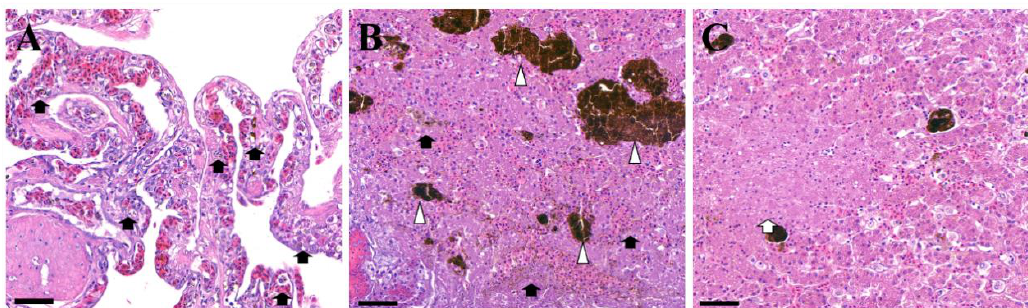
Figure 2. Microscopic examinations. Shown are the microscopic findings in the ( A ) lung and ( B ) liver tissues. HE staining shows the presence of several melano-macrophage centers (arrowhead) and diffused melano-macrophages (black arrow). Necrotic lesion in liver (white arrow, C ). (bar = 60 µm).